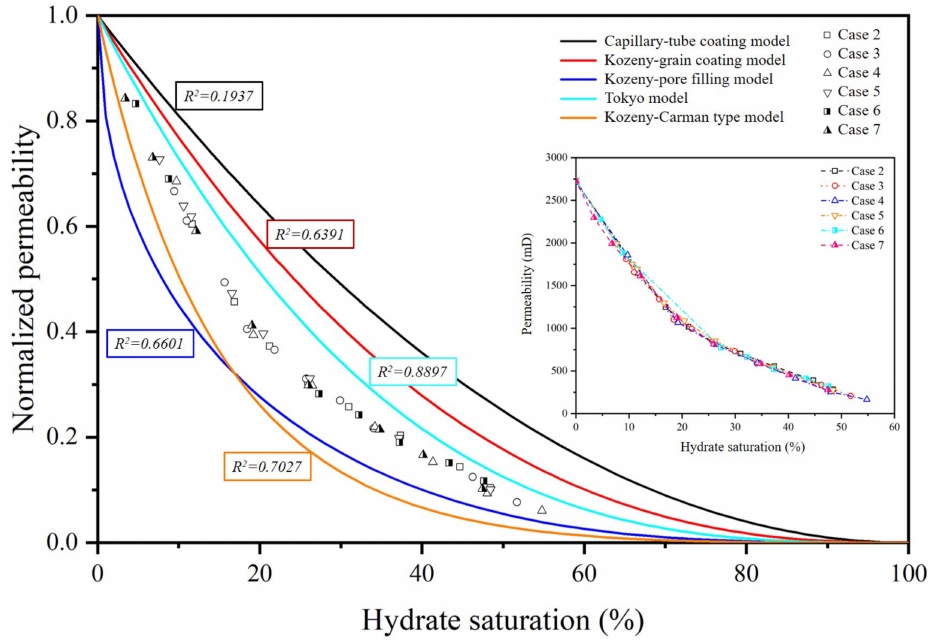
Figure 39. Comparison of normalized gas permeability between experimental results and perme- ability model predictions reprinted from [69] with permission from Elsevier. The adopted existing analytical models are from literatures